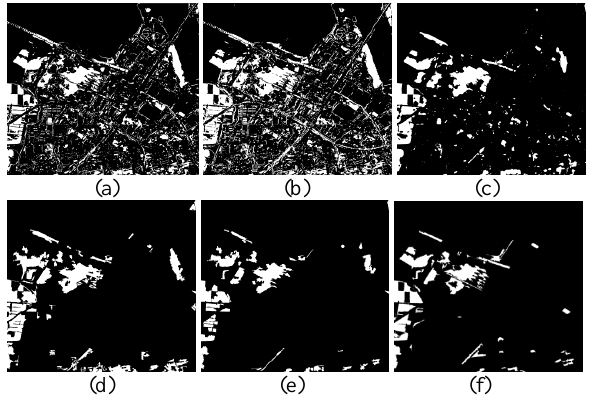
Figure 7. The results of different methods. (a) MRF-ICM; (b) PCA-kMeans; (c) DRLSE; (d) OCVA; (e) Proposed; (f) Reference